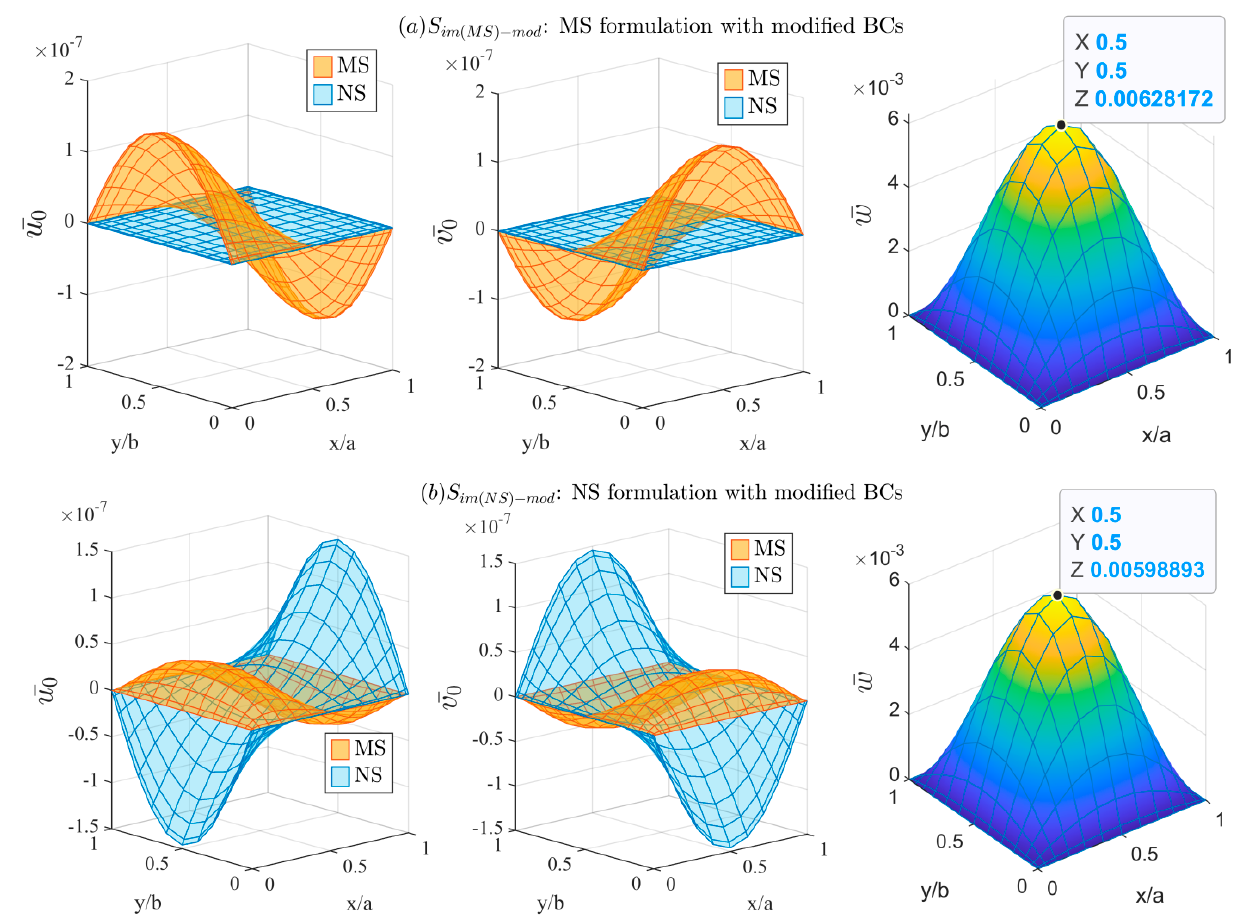
Figure 7. Solutions generated by ( a ) MS and ( b ) NS formulations by the classical BCs (Equation (20)) for an immovable simply supported 𝑆 (cid:3036)(cid:3040) square plate (𝑎/ℎ = 100, 𝑛 (cid:3053) = 0.5) .